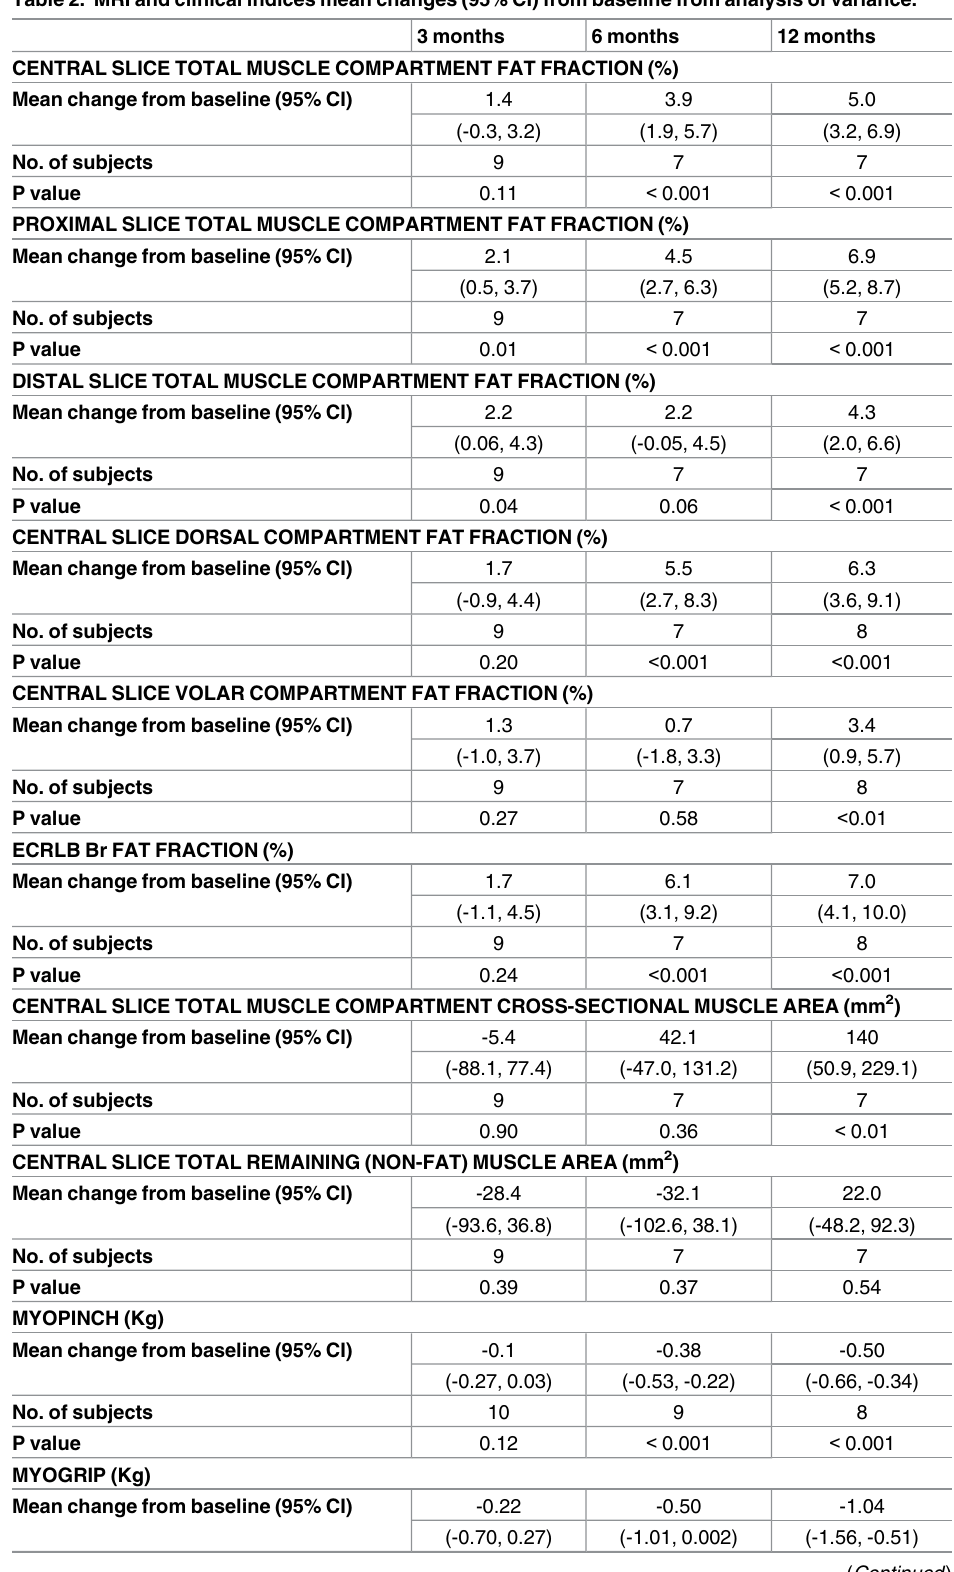
Table 2. MRI and clinical indices mean changes (95% CI) from baseline from analysis of